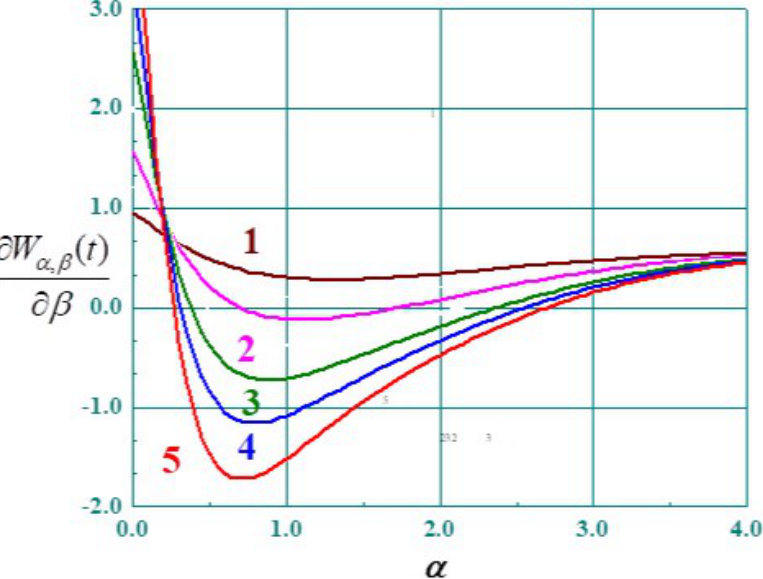
Figure 3. Derivatives of the Wright functions with respect to parameter β as a function of α for β = 1 and 1 : t = 0.5; 2 t = 1.0; 3 t = 1.5; 4 : t = 1.75; 5 t = 2.0.